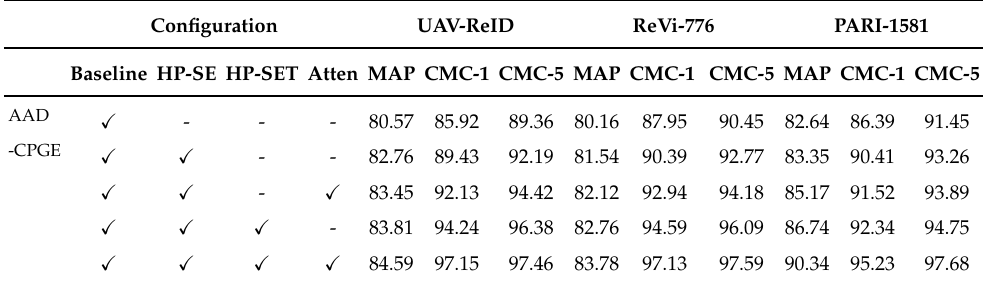
Table 5. Comparisons results(%) of object Re-ID on UAV-ReID, ReVi-776 and PRAI-1581 dataset by using the metrics of mAP, CMC-1 and CMC-5,